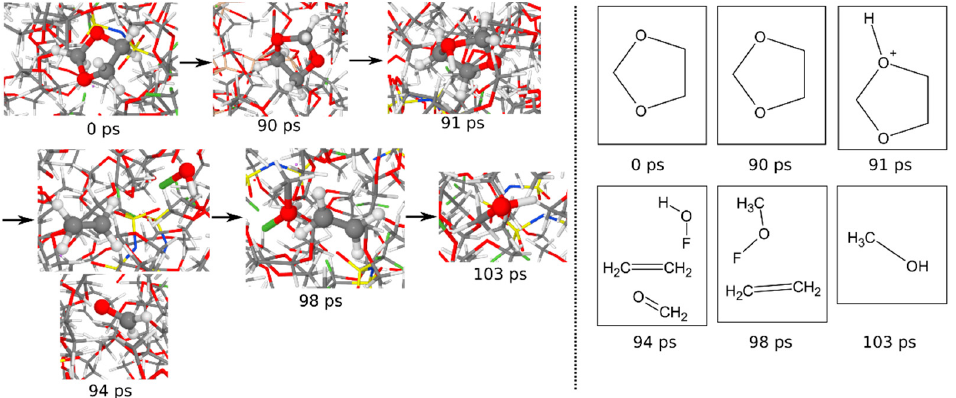
Figure 13. Decomposition mechanism of an exemplary chosen DOL molecule in the 0.7 M system. Shown are trajectory screenshots as well as the effective Lewis structures of the visible parts.